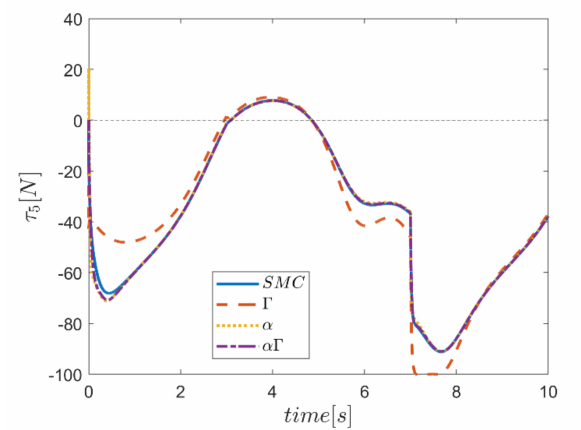
Figure 54. Comparison of the input force in the fifth actuator.